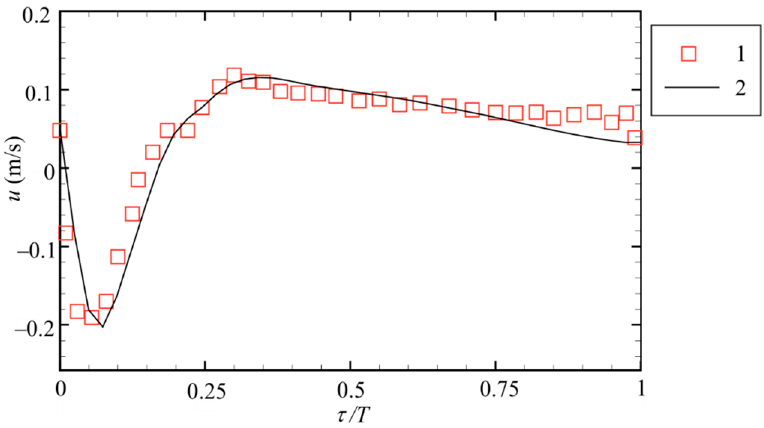
Figure 4. The pulsating velocity at f = 0.5 Hz, A / D = 3, Re = 500: 1—experimental data [42]; 2—numerical simulation.